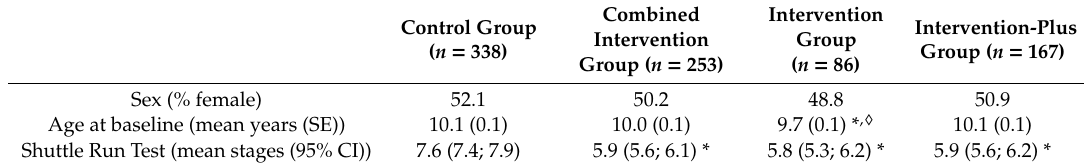
Table 2. Baselinecharacteristicsofstudyparticipantsforallcovariatesandoutcomesbyexperimentalcondition.